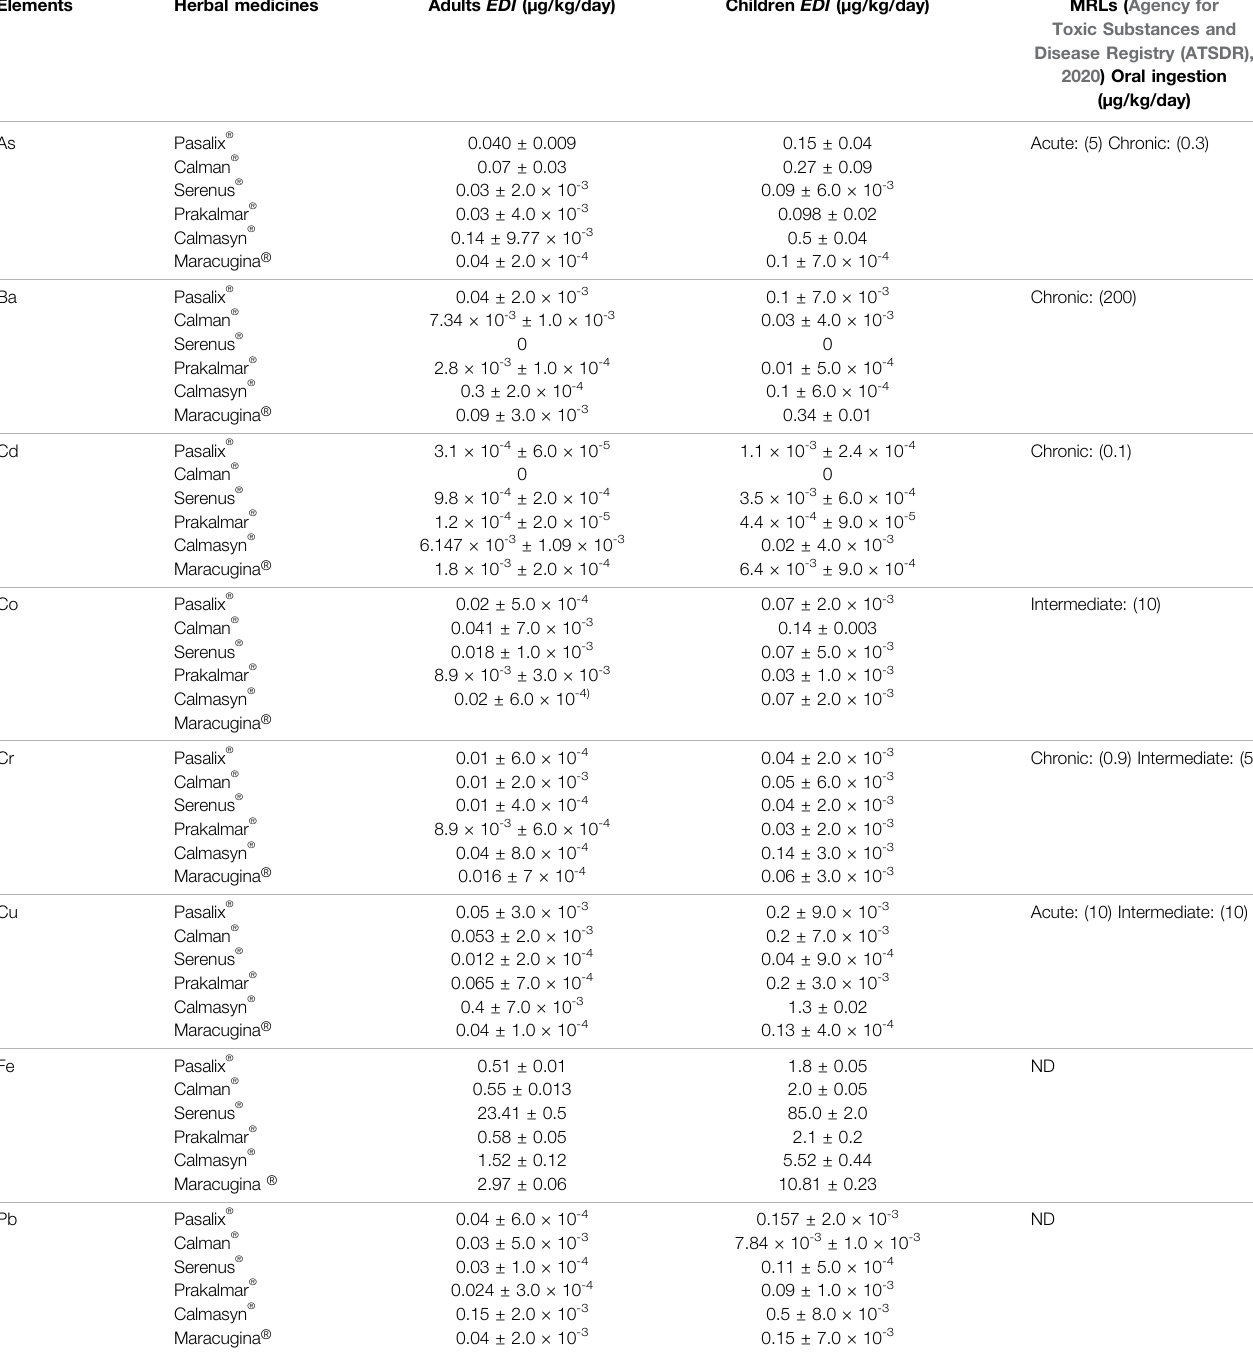
TABLE 7 | Herbal medicines, estimated daily intake ( EDI ) of elements in adults and children (µg/kg/day) through the consumption of herbal medicines compared with MRLs levels. Elements Herbal